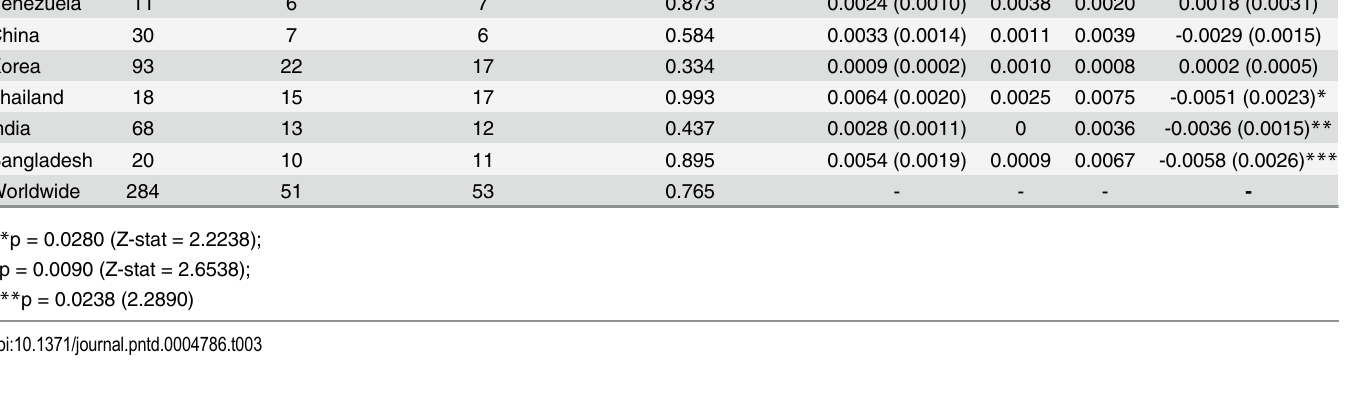
diversity was observed for pvs28 in Bangladesh (Hd = 0.895), Thailand (Hd = 0.993) for Asia, and Venezuela (Hd = 0.873) from the Americas (Table 3). For pvs25 , high haplotype diversity was observed in samples from China (Hd = 0.6478), Venezuela (Hd = 0.8000), and Mexico (Hd = 0.6513) (Table 4).